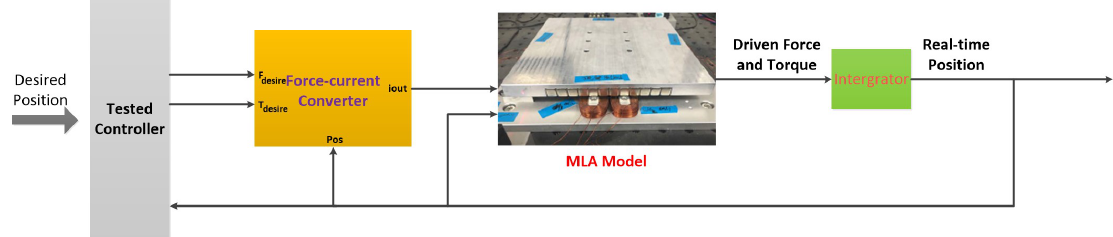
Figure 1. Scheme of the simulator for the magnetically levitated actuator